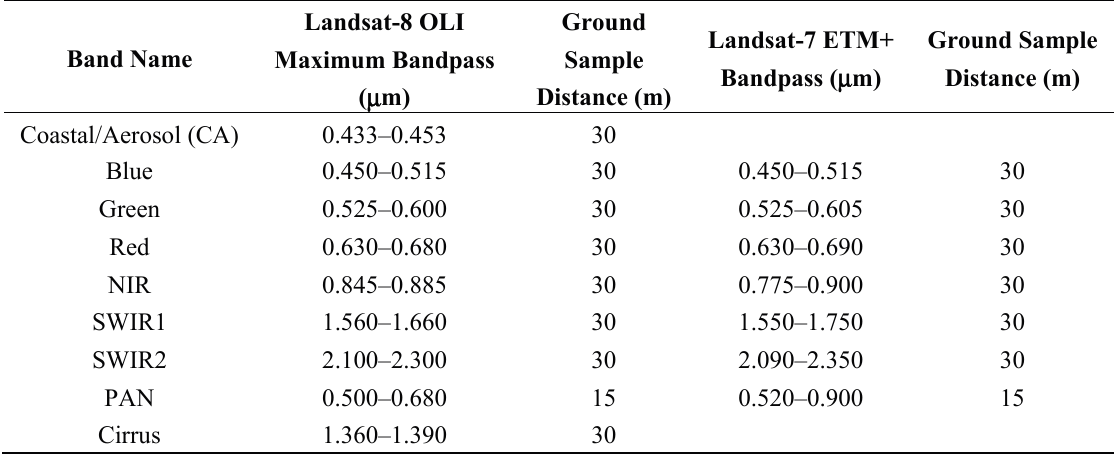
Table 1. Landsat-8 Operational Land Imager (OLI) spectral band requirements as compared to Landsat-7